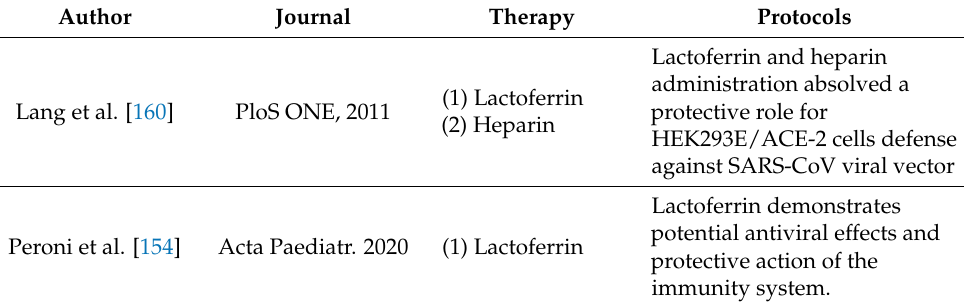
Table 3. Overview of COVID-19 lactoferrin supporting